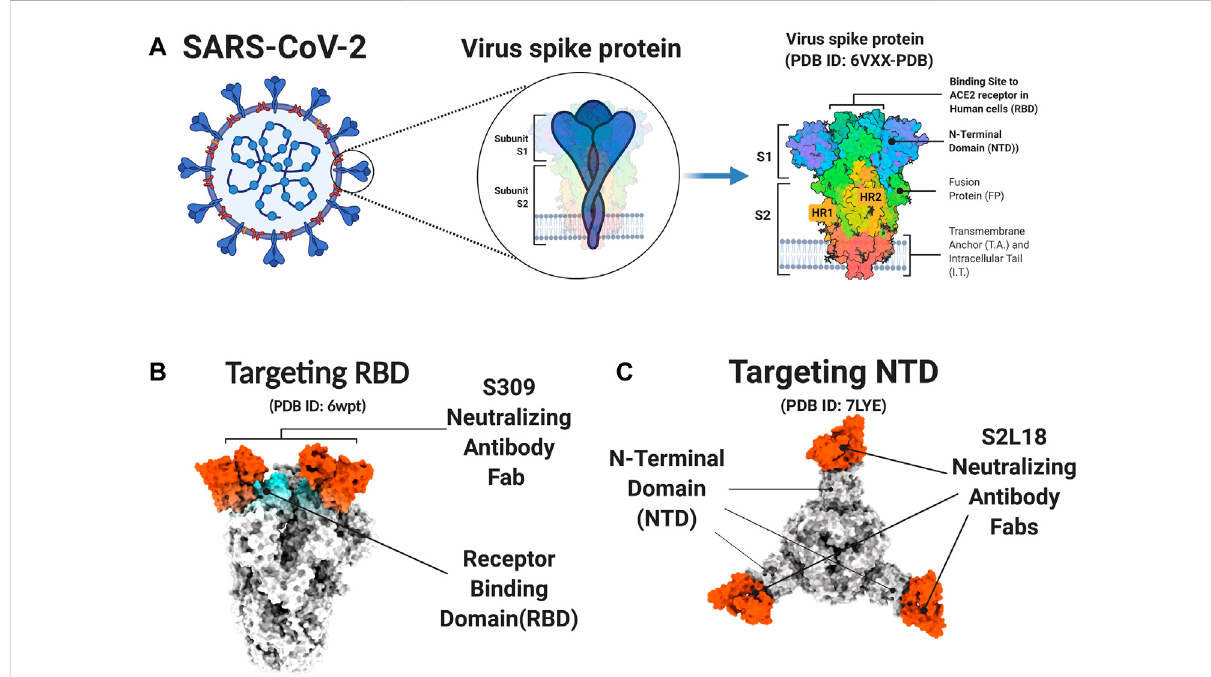
FIGURE 2 S protein and neutralizing antibody. (A) The Structure of the SARS-CoV2 S Glycoprotein. (B-C) The PDB model of S protein and neutralizing antibody. The S309 neutralizing antibody targets the receptor-binding domain (RBD) of S protein (B) The S2L18 neutralizing antibody targets the N-terminal domain (NTD) of S protein (C) . Figure was generated by